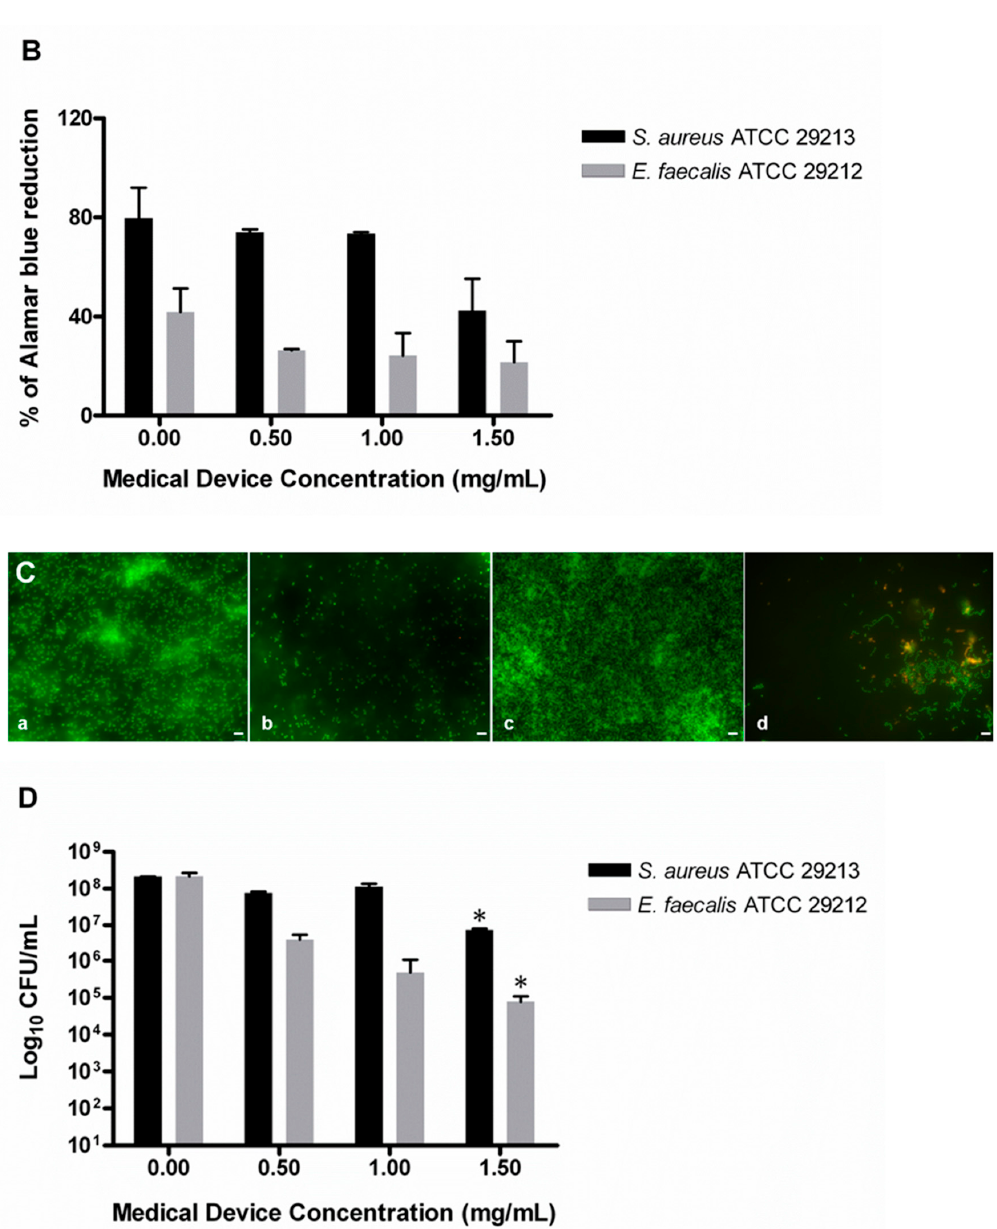
Figure 2. Evaluation of minimum biofilm inhibitory concentration (MBIC) of the medical device (MD) versus S. aureus and E. faecalis biofilm determined by AB assay, live / dead staining, and fluorescent microscopy analysis and colony-forming unit (CFU) counts. ( A ) Representative image of colorimetric MIC determination using AB assay. The black circle indicates the MBIC at 1.5 mg / mL, which is the same for both S. aureus and E. faecalis . ( B ) The plot shows the percentage reduction of AB recorded for S. aureus and E. faecalis at di ff erent MD concentrations compared to the corresponding untreated samples (0.00), as previously described. The percentage of AB reduction was evaluated by using absorbance at 570 nm and 600 nm. ( C ) Representative images of live / dead staining of S. aureus and E. faecalis biofilm developed with and without the addition of MD at the inoculum. S. aureus biofilm after 24 h of incubation: (a) S. aureus treated with 1.5 mg / mL of MD at the inoculum, (b) E. faecalis biofilm after 24 h of incubation, (c) E. faecalis treated with 1 mg / mL of MD, (d) the green fluorescence indicates live cells; the samples treated with the MD did not develop a biofilm, as shown in images (b and d). bar: 5 µ m. ( D ) Evaluation of the CFU number in the MD-treated and untreated sample. A significant reduction was detected at 1.50 mg / mL in both the microorganisms. Data are the mean of three replicates of three independent experiments; * p < 0.05 vs. the controls (0.00). C: controls or untreated samples.